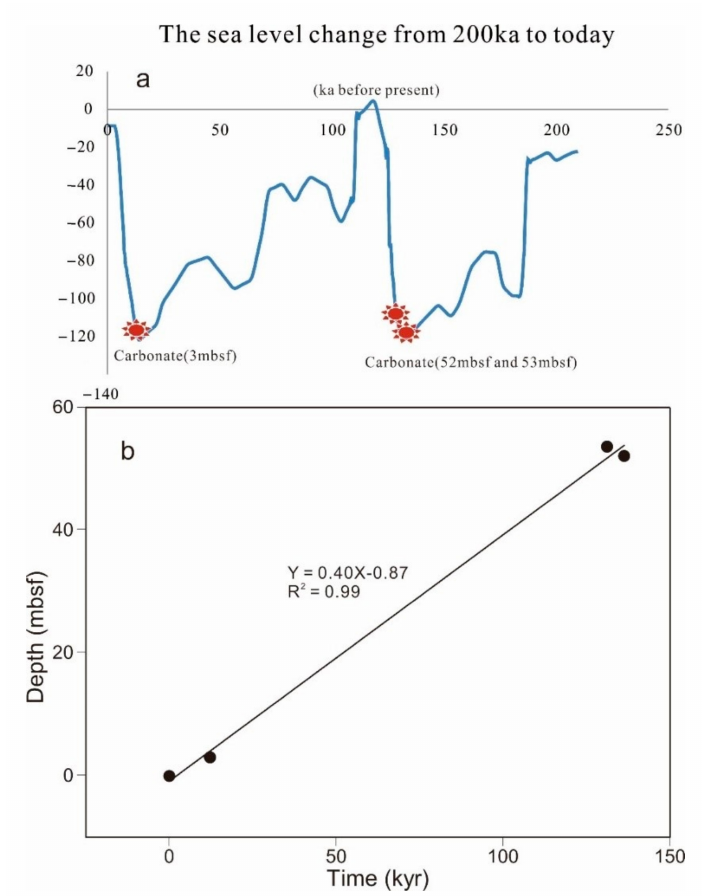
Figure 6. ( a ) The sea level change [59] and the distribution of carbonate. The sun symbols represent the time of carbonate formation. ( b ) The sedimentation rate estimated based on the U-Th carbonate ages.